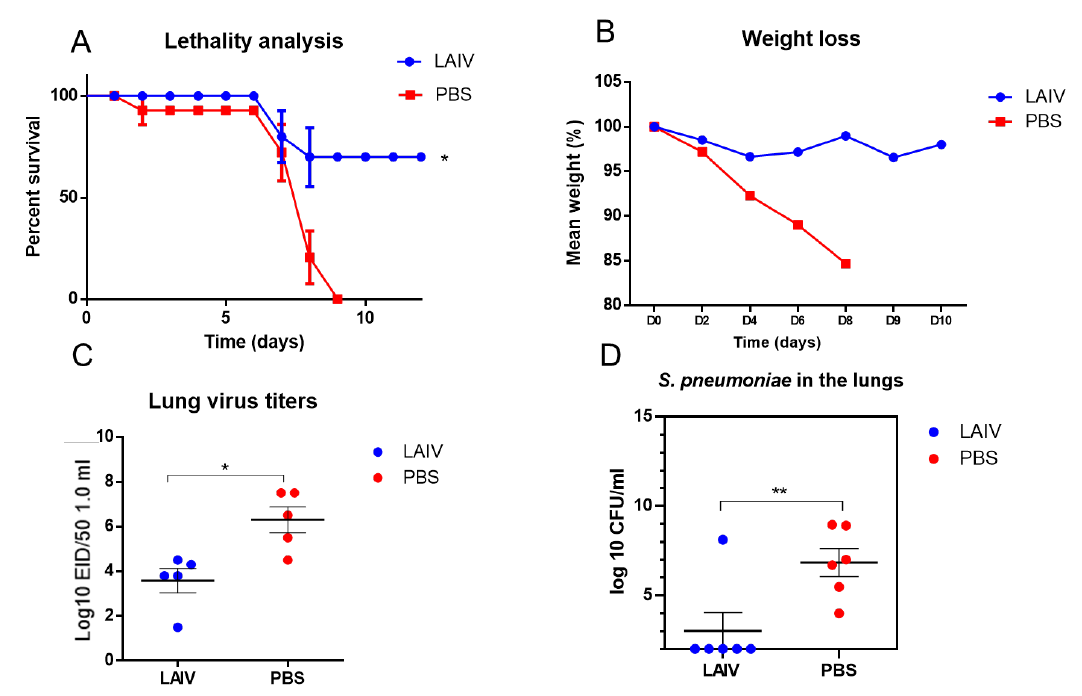
Figure 6. Protection against A/South Africa/3626/2013(H1N1) pdm09 influenza challenge, followed by S. pneumoniae infection 3 days apart. * p < 0.05, ** p < 0.01 compared to PBS group. The mice were immunized twice using trivalent LAIV 2017–2018 years of formulation. ( A ) The survival rate ( n = 10 in group). ( B ) Weight loss ( n = 10 in group). ( C ) Infectious-virus isolation from the lungs 48 h after virus challenge ( n = 5). ( D ) S. Pneumoniae levels in the lungs of mice 48 h after bacterial superinfection. This was expressed by the fact that mortality decreased to 30%, and weight loss decreased as well (Figure 6A,B). Vaccination with LAIV not only led to a decrease in the levels of the infecting virus in the lungs (Figure 6C), but also reduced the pneumococcal contamination of the lungs (Figure